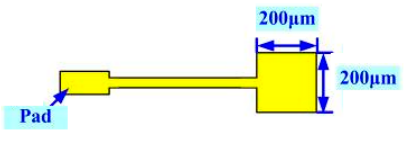
Figure 2. Design of micro voltage sensor.